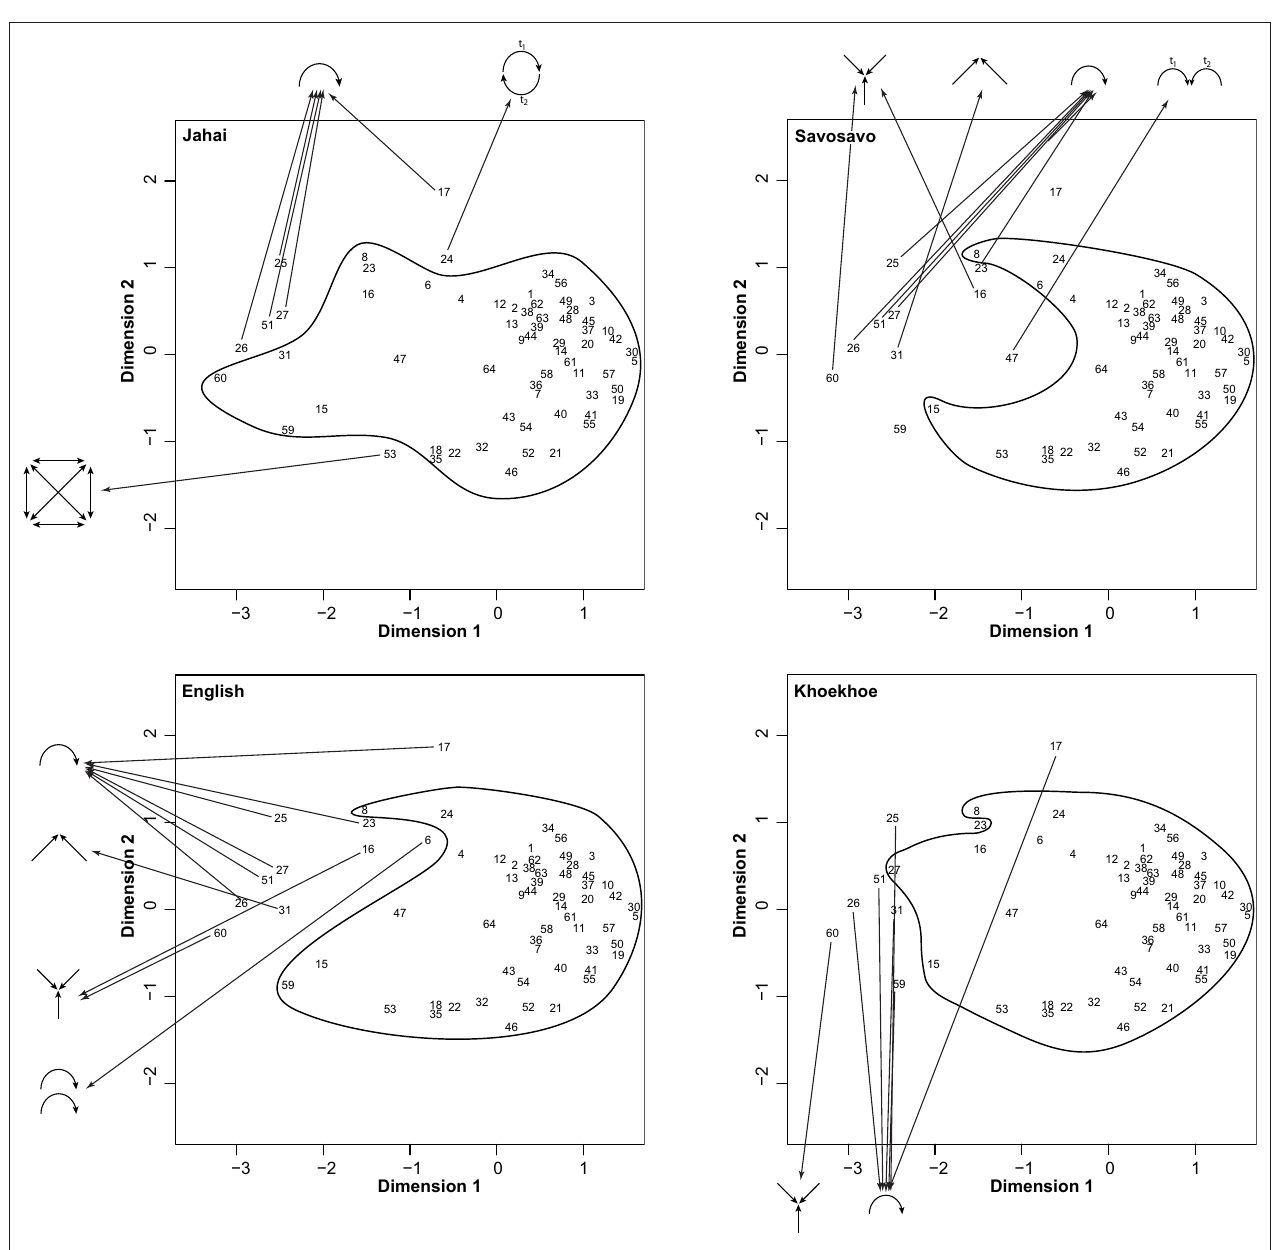
FigurE 7 | Extensional range for general reciprocal constructions in Jahai (top left), Savosavo (top right), English (bottom left) and Khoekhoe (bottom